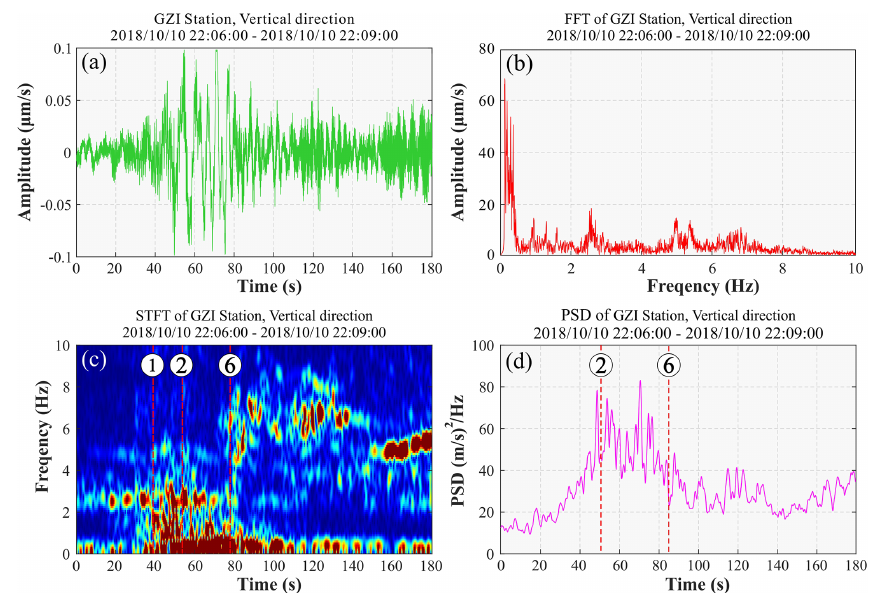
Figure 7. Seismic signals of the Baige landslide as recorded at seismic station GZI. (a) Vertical seismic signal; (b) frequency spectrum; (c) time–frequency spectrum and the key times picked frequency from it, i.e., start time, first acceleration, and third deceleration, from left to right respectively; and (d) power spectral density (PSD) curve and the key times picked from it, i.e., first acceleration and third deceleration.